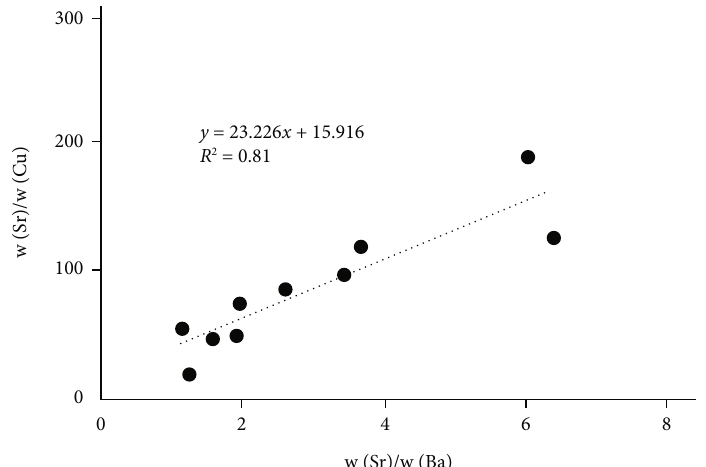
Figure 6: w(Sr)/w(Ba) and w(Sr)/w(Ba) relationship of the fi rst member of Luzhai Formation in Rongshui area.